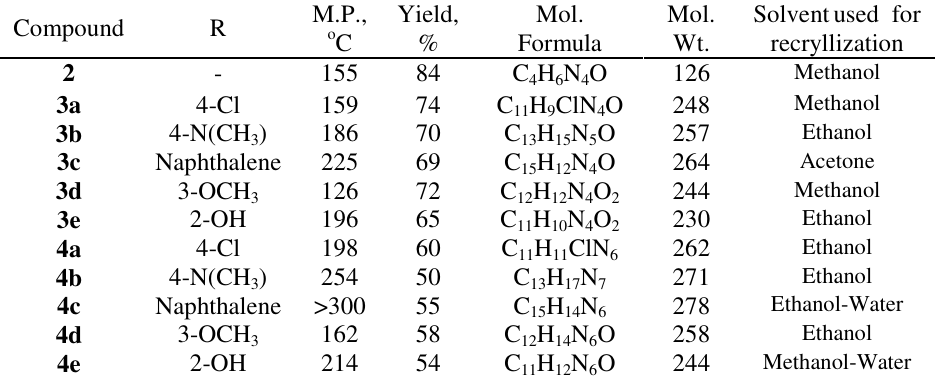
Table 1. Physical data of synthesized compounds 2, 3a-e and